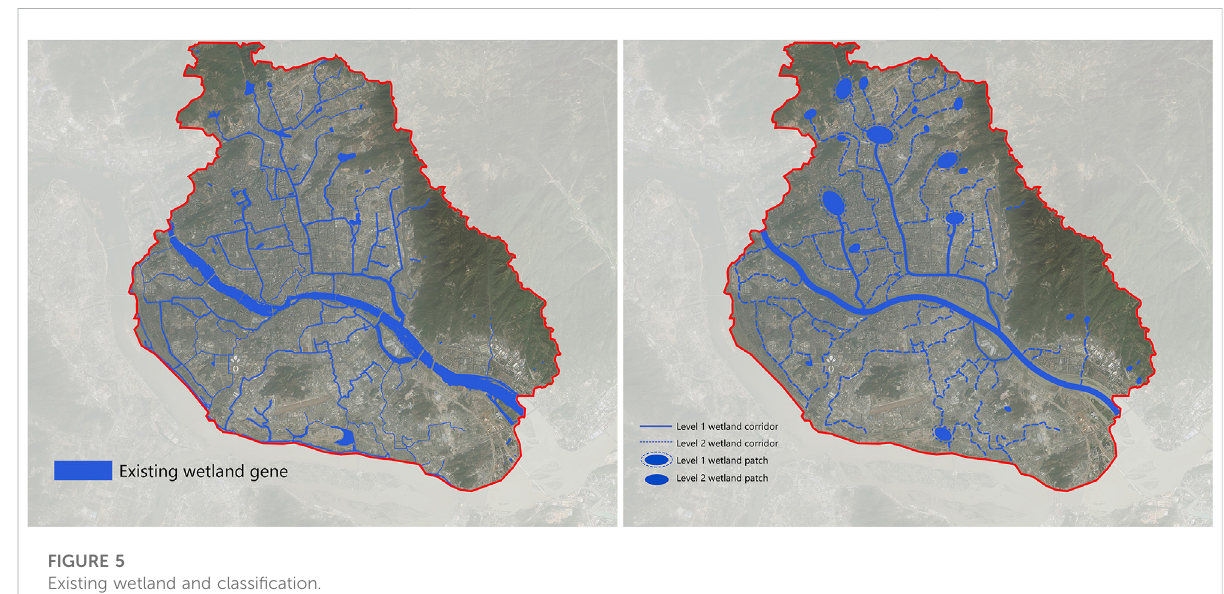
FIGURE 5 Existing wetland and classi fi